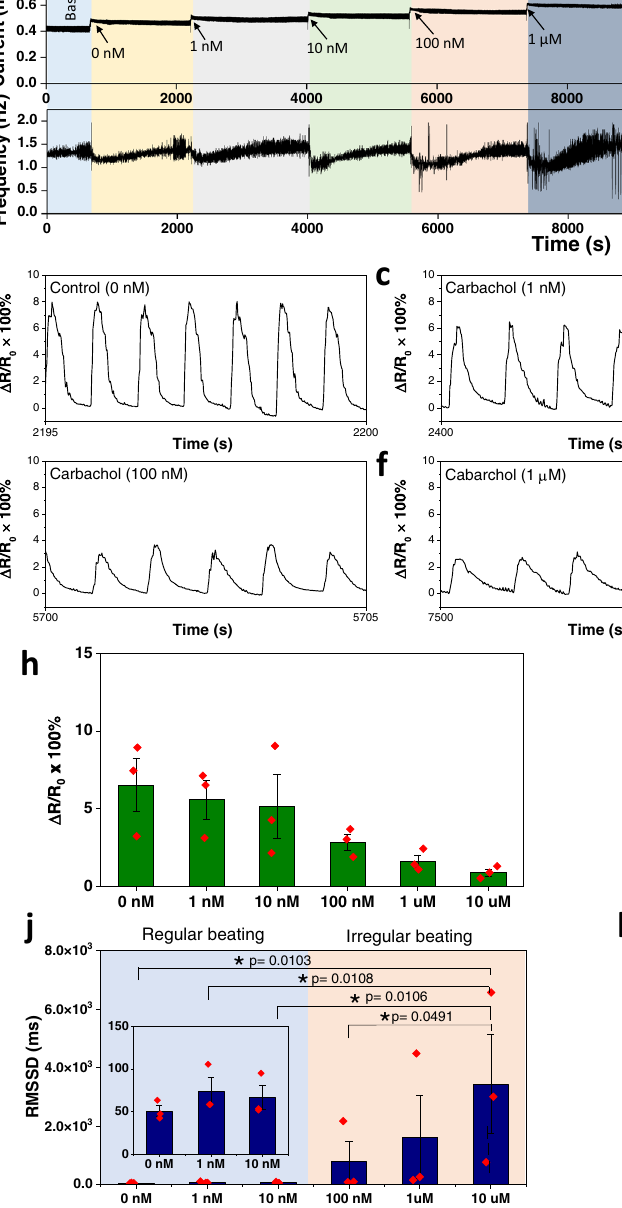
10 μ M( f )carbacholdosageinatime-dependentmanner. h – k Barplotdepictingthe resistancechanges ( h ),frequencychanges ( i ), RMSSD ( j ),and rise time/decay time ( k ) of the organoids ( n =3). Data are presented as mean±SEM. Statistical analysis was performed using one-way ANOVA with a Bonferroni post hoc test (* p <0.05, ** p <0.01, *** p